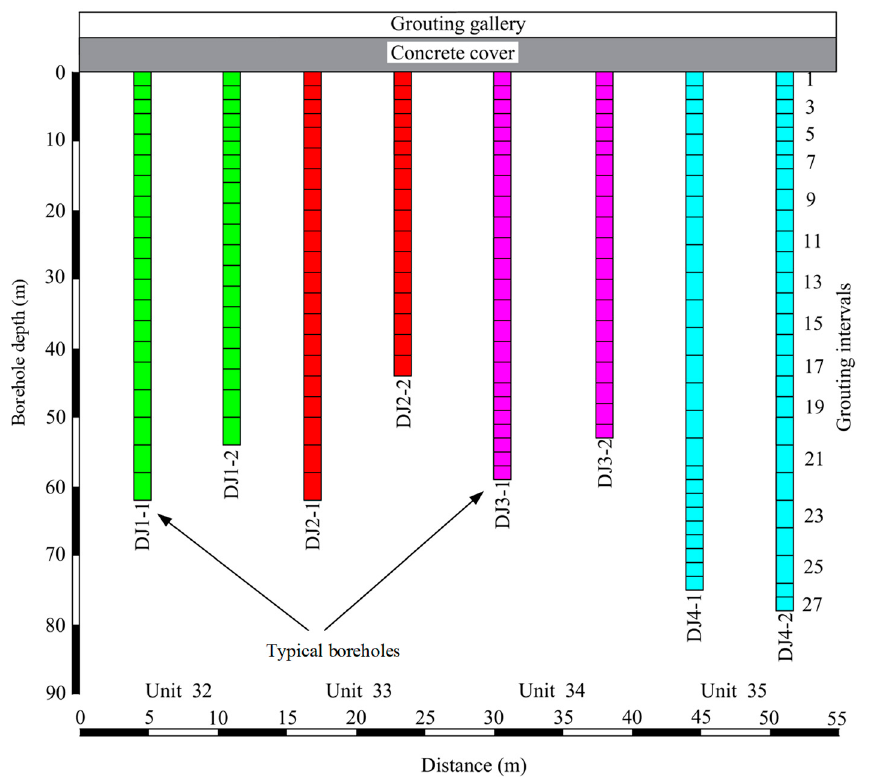
Figure 7. Longitudinal section of the grouting verification hole in the study area.